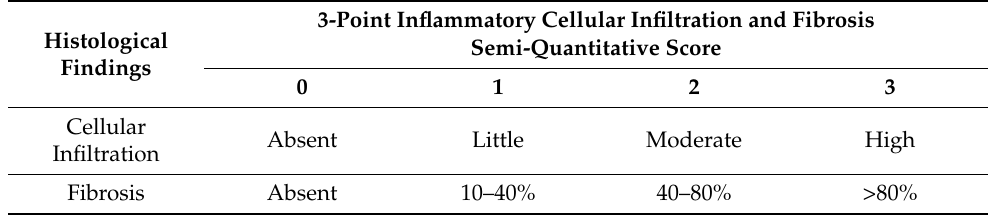
Table 5. Histological score of inflammatory infiltrate and fibrosis according to Mansueto et al. 3-Point Inflammatory Cellular Infiltration and Fibrosis Histological Semi-Quantitative Score Findings Cellular Absent Little Moderate High Infiltration Fibrosis Absent